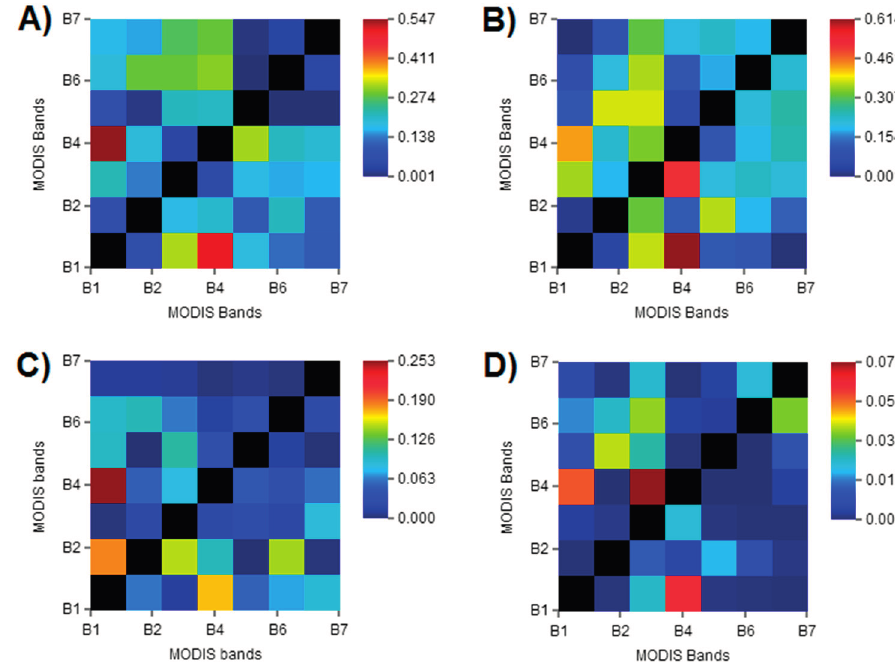
Figure 6. 2D correlation plots of MOD09GA spectral bands using ICE [37]. ( A ) JFM; ( B ) AMJ; ( C ) JAS; ( D )